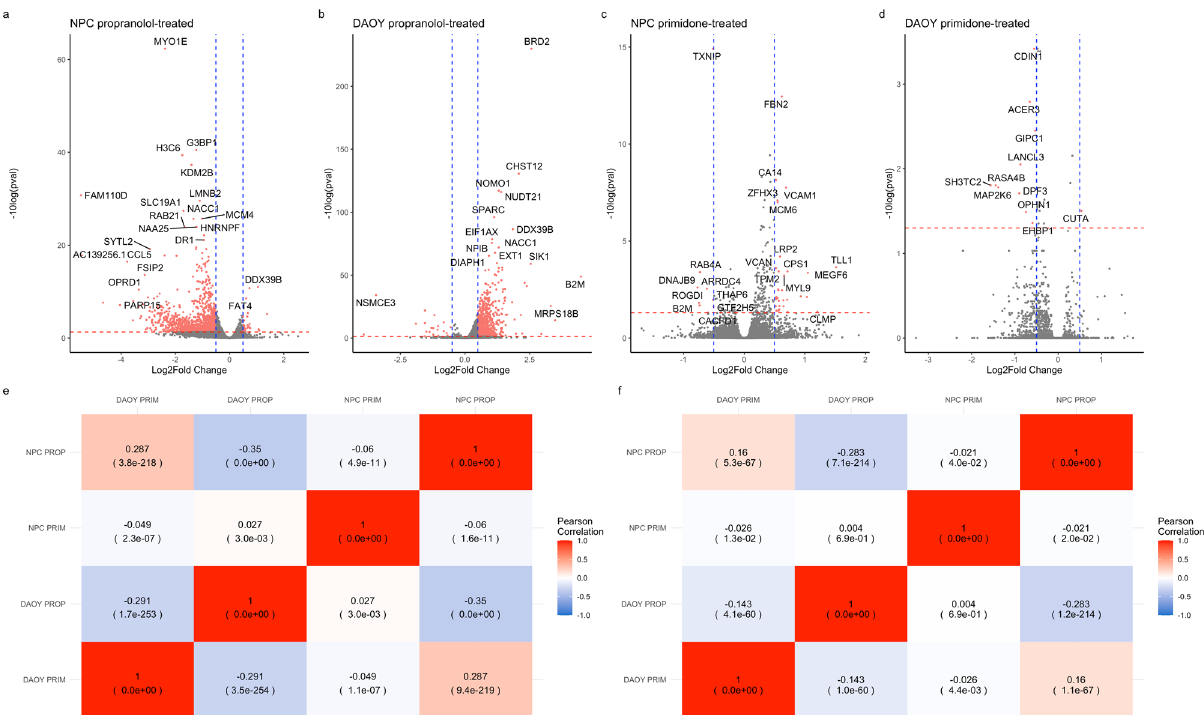
Fig. 1 Correlation between DAOYs and NPCs treated with propranolol and primidone. Volcano plots of propranolol-treated NPCs a and DAOYs b as well as primidone-treated NPCs c and DAOYs d . Blue lines indicate − 0.5- and 0.5-Log2FC changes. Red lines indicate q value signi fi cance threshold (0.05). e Unweighted Pearson correlations between DEGs z -scores from different conditions of treatment and cell types. f Weighted Pearson correlations between DEGs z -scores from different conditions of treatment and cell